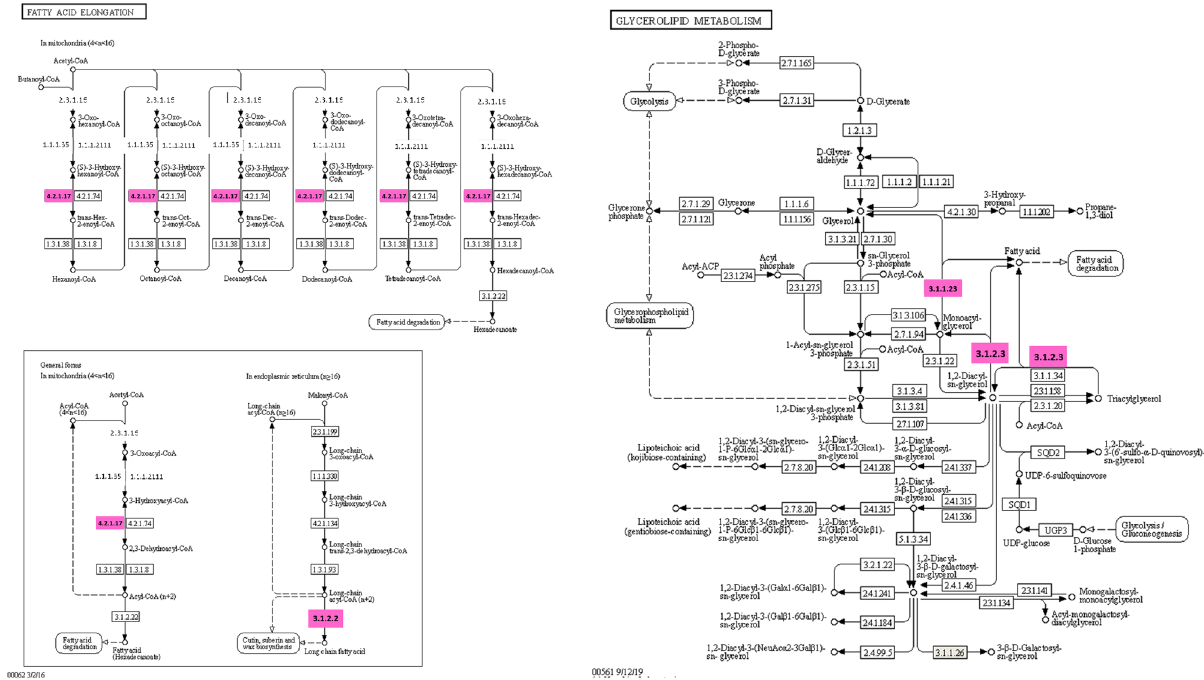
Figure 8. Fatty acid elongation and glycerolipid metabolism. Pink boxes: downregulated proteins in the HFLac